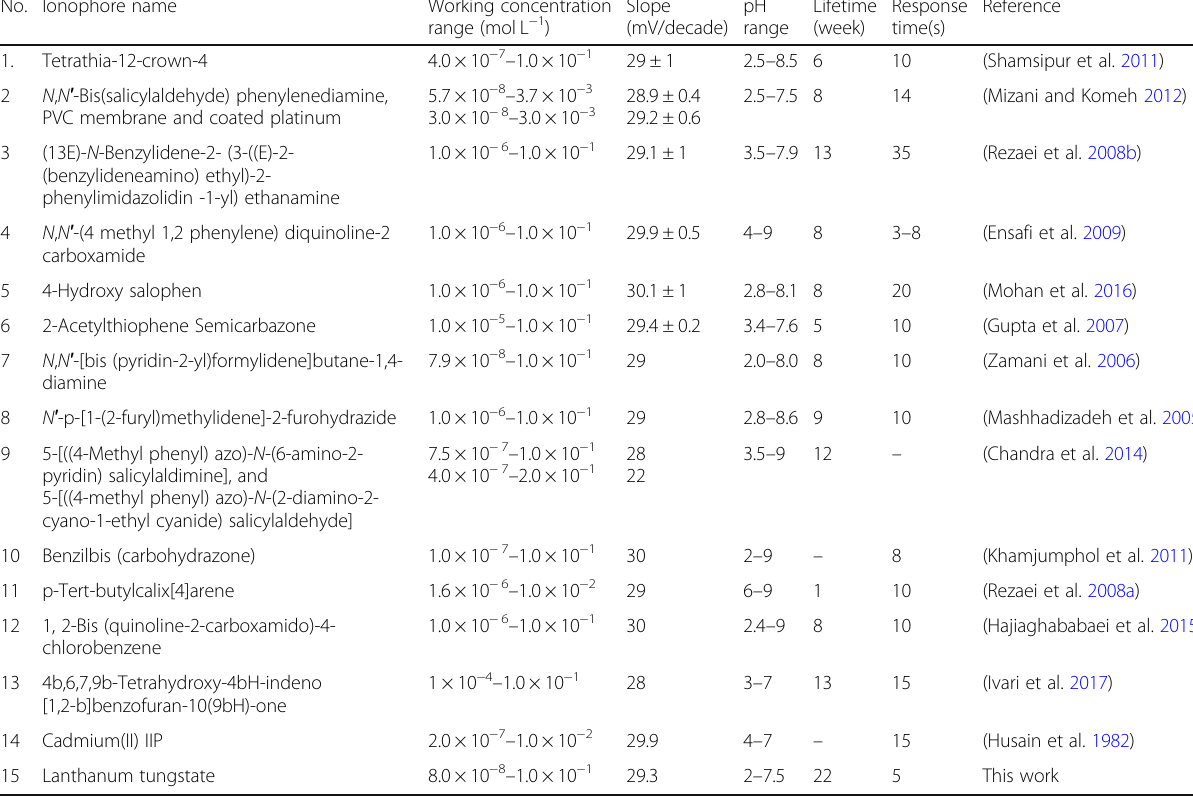
the previously reported sensor systems corresponding to Table 2 Potentiometric parameters of the modified Cd(II)-CPE and other